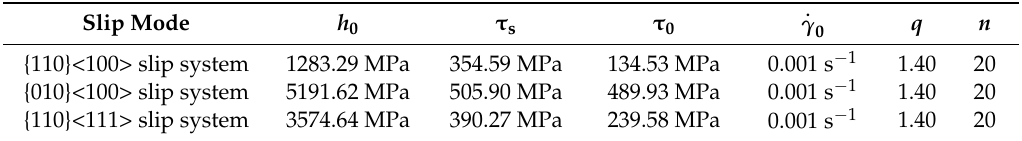
Figure 9. The convergence of PSO algorithm in the aspect of parameter identification and the validity of material parameters: ( a ) fitness function convergence as a function of generation number; ( b ) macroscopic stress-strain response of NiTi SMA subjected to uniaxial compression based on compression experiment and crystal plasticity finite element simulation. Table 1. Material parameters of as-received NiTi SMA used for